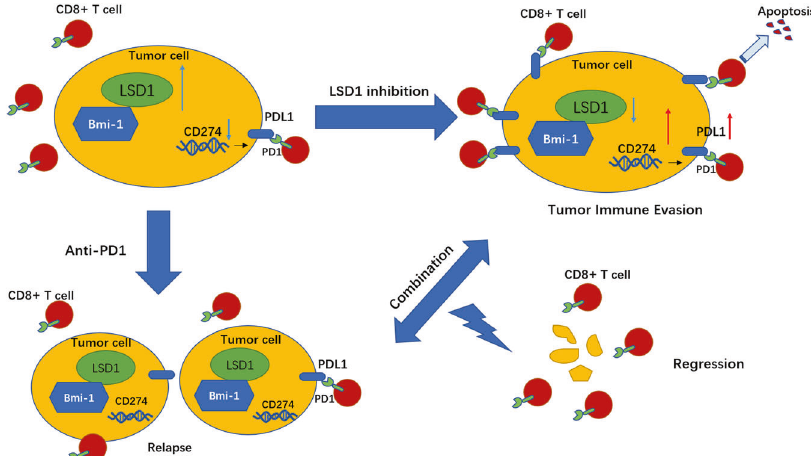
Fig. 7 Characterization of the immune cell pro fi le of tumor tissues after SP2509 inhibition and anti-PD-1 treatment. A – D Both fl ow cytometric analysis and IHC staining were used to identify the changes in PDL1 expression in tumor tissues after SP2509 inhibition and anti- PD-1 treatment. A Representative IHC images of PDL1 in tumor sections from each treatment group. B The histograms show that the percentages of PDL1-positive cells per fi eld were similar between each treatment group and the untreated group. C Representative FACS images of PDL1 in tumor cells from each treatment group. D The histograms show the percentages of PDL1-positive cells in each treatment group based on FACS analysis. Both SP2509 treatment alone and combination treatment with SP2509 and the anti-PD-1 antibody resulted in a signi fi cant increase in PDL1 expression in tumor tissue compared with vehicle treatment. E – N Numbers of different subsets of immune cells in tumor tissue determined from the percentage of the total immune cell population (CD45 + ) of mice treated with the inhibitor SP2509 and PD-